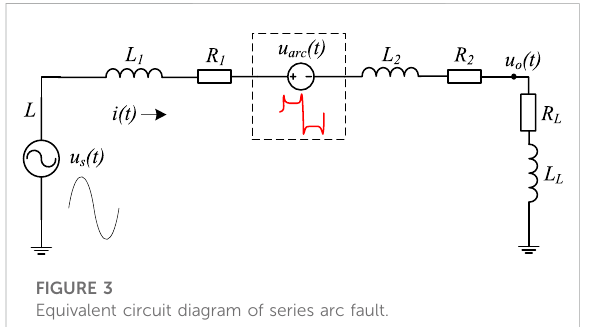
FIGURE 3 Equivalent circuit diagram of series arc fault.